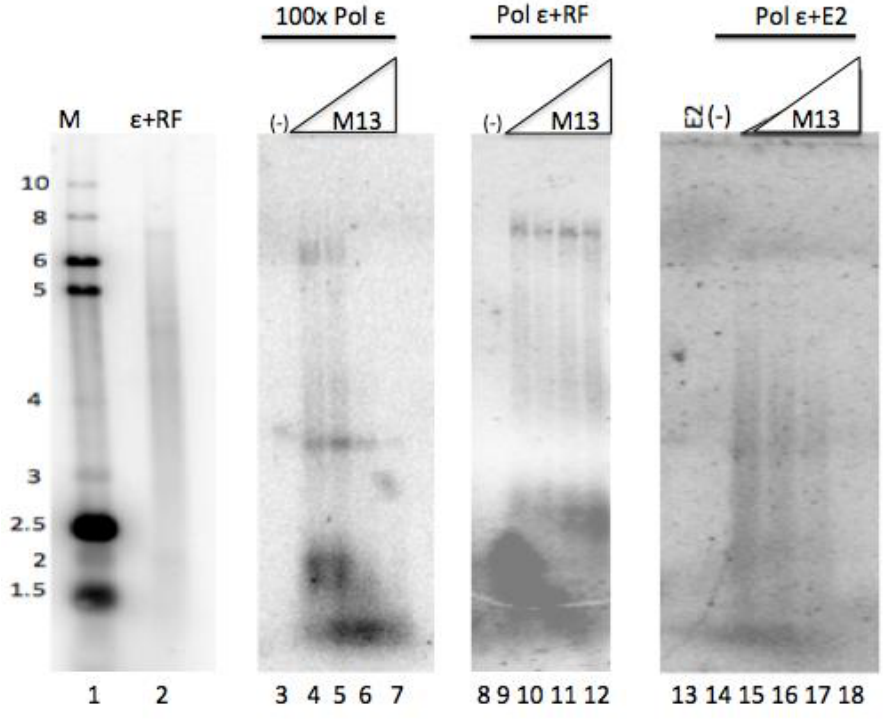
Figure 3. E2 does not confer processivity to pol ε . Pol ε processivity was examined by performing primed M13 reactions under conditions in which template was in vast excess of polymerase [28,29]. Pol ε (0.1 ng/ µ L, 2.9 fmoles) was incubated with E2 (40 ng/ µ L) with increasing concentrations of template (5–40 fmoles, lanes 15–18) or with RF (as described in Methods) with increasing concentrations